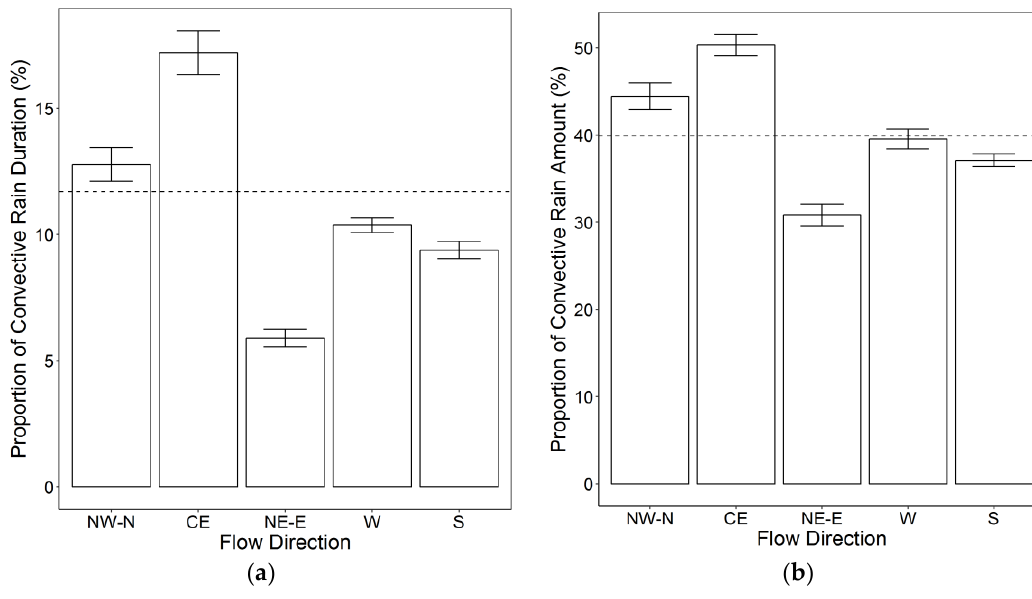
Figure 3. Proportion of convective rain ( a ) duration and ( b ) amount averaged over the 16 devices within each flow direction (cf. Table 1). Error bars are based on the standard error. Dashed lines represent the overall proportion of the convective rain duration and amount.